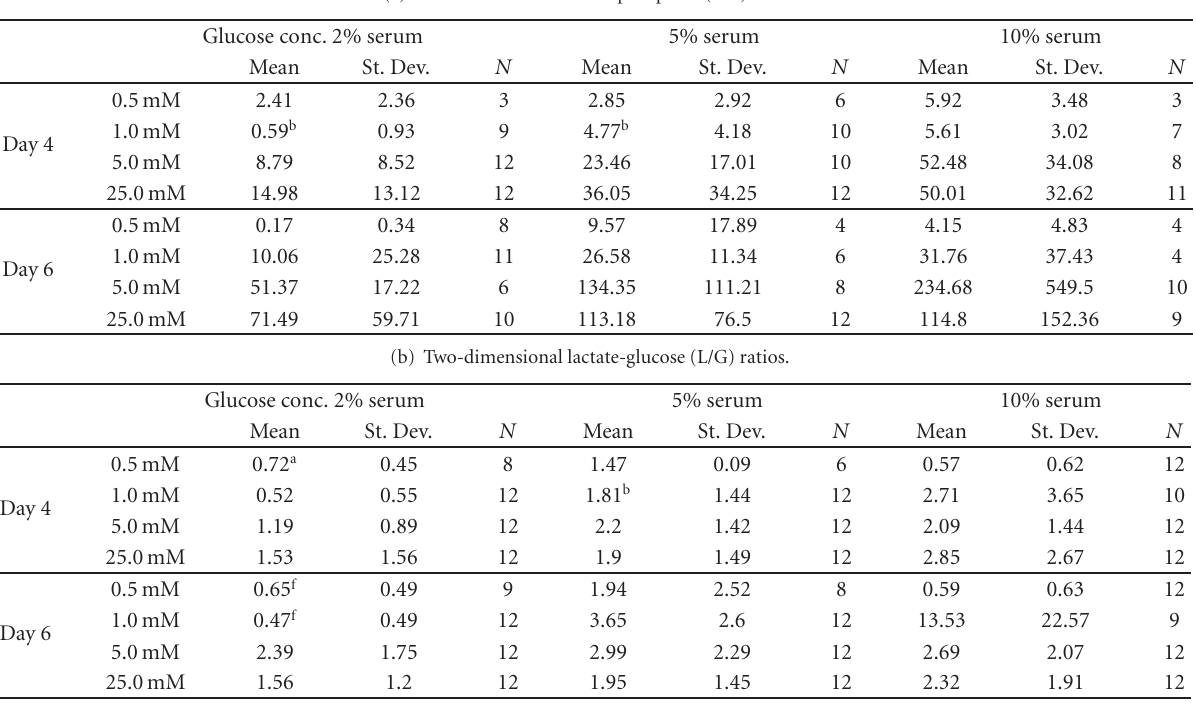
Table 1: Summary of two-dimensionalL/P ratios and L/G ratios. L/P ratios indicate that groups with a higher starting glucose concentration exhibited a more anaerobic characteristic. This trend was similar in the L/G ratios for the 2% serum group, but not for either the 5% or 10% serum groups. (a: significantly di ff erent from corresponding value in the 5.0mg/mL group; b: significantly di ff erent from the 25.0mM value within the same collagen group; f: significantly di ff erent from 5.0mM value within same serum group; P = . 05).